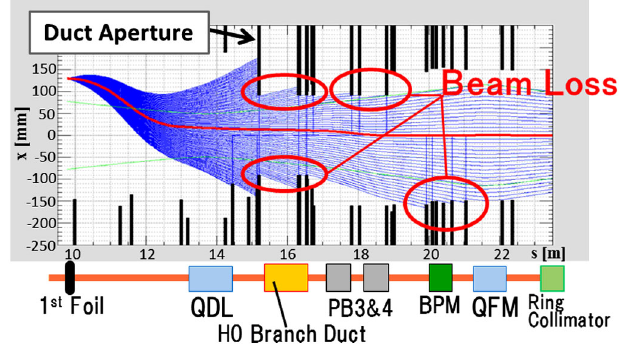
FIG. 2. Tracking simulation of the horizontally scattered beam. The blue lines are the tracks of particles that gave arbitrary angles at the injection point. The green lines indicate the 486 (cid:2) mm mrad beam